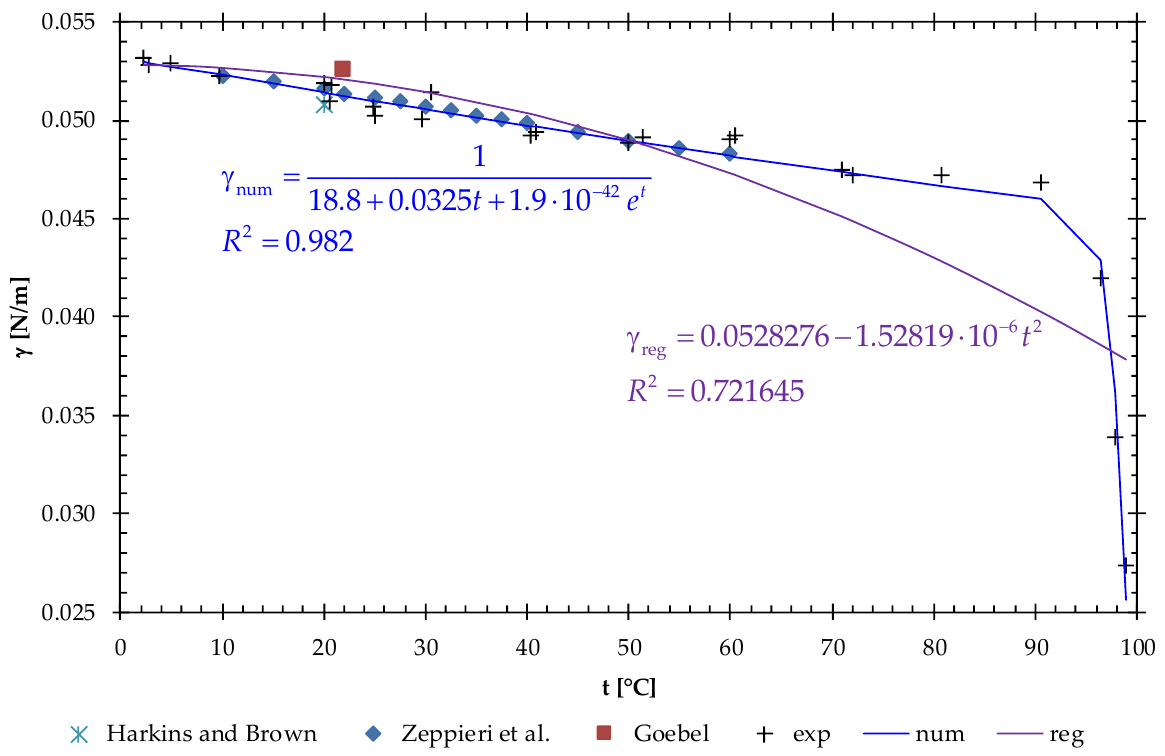
Figure 9. Harkins and Brown [43], Zeppieri et al. [44], Goebel (after Knovel [45]), exp—the outcomes of the present experiments, num—the best numerical approximation of the experimental outcomes— the results of Equation (50), reg—the results of Equation (51).